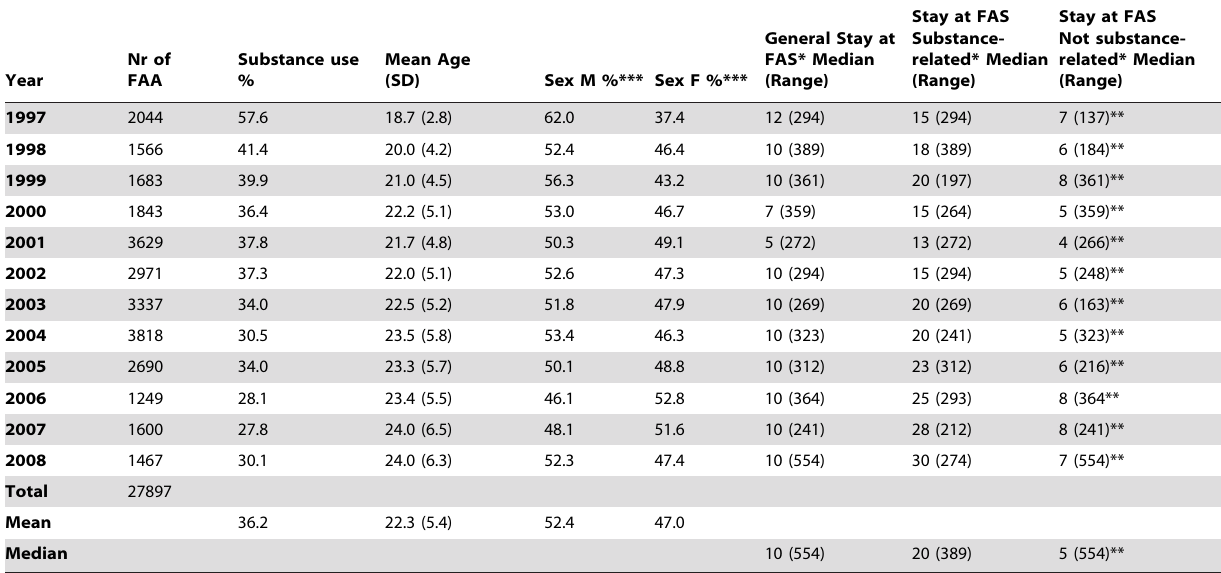
Table 1. Characteristics of visitors at first aid